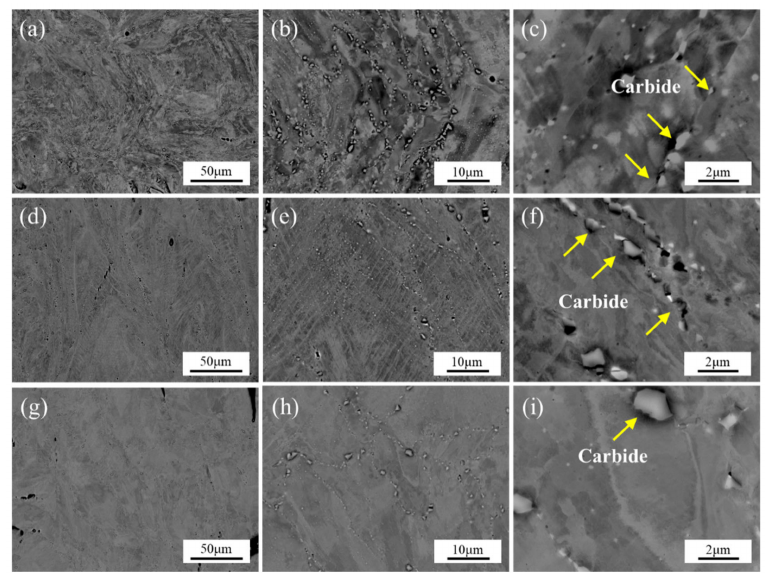
Figure 6. Microstructure changes after heat treatment: ( a – c ) transverse microstructure; ( d – f ) longitu- dinal microstructure; and ( g – i ) 45 ◦ microstructure.